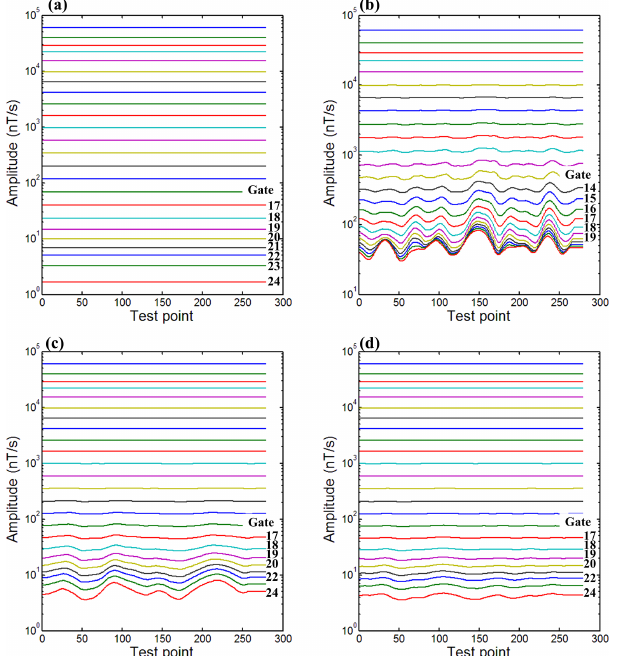
Figure 3. Anomaly curve profile image generated from different processed datasets. The duration of raw data is 60s and the stack- ing interval is 0.2s; therefore the number of test points is 300. (a) The clean signal from the theoretical model; (b) the noisy sig- nal containing baseline wander; (c) the correctional signal using the wavelet-based method; (d) the correctional signal using the EEMD- AF method. The label gate marked in each panel represents the number of time gates from 1 to 24. Every specific number of a time gate means a different time width, which increased logarithmically. The vertical coordinates are changed to logarithmic format in order to facilitate the display of detail of each gate in each panel.